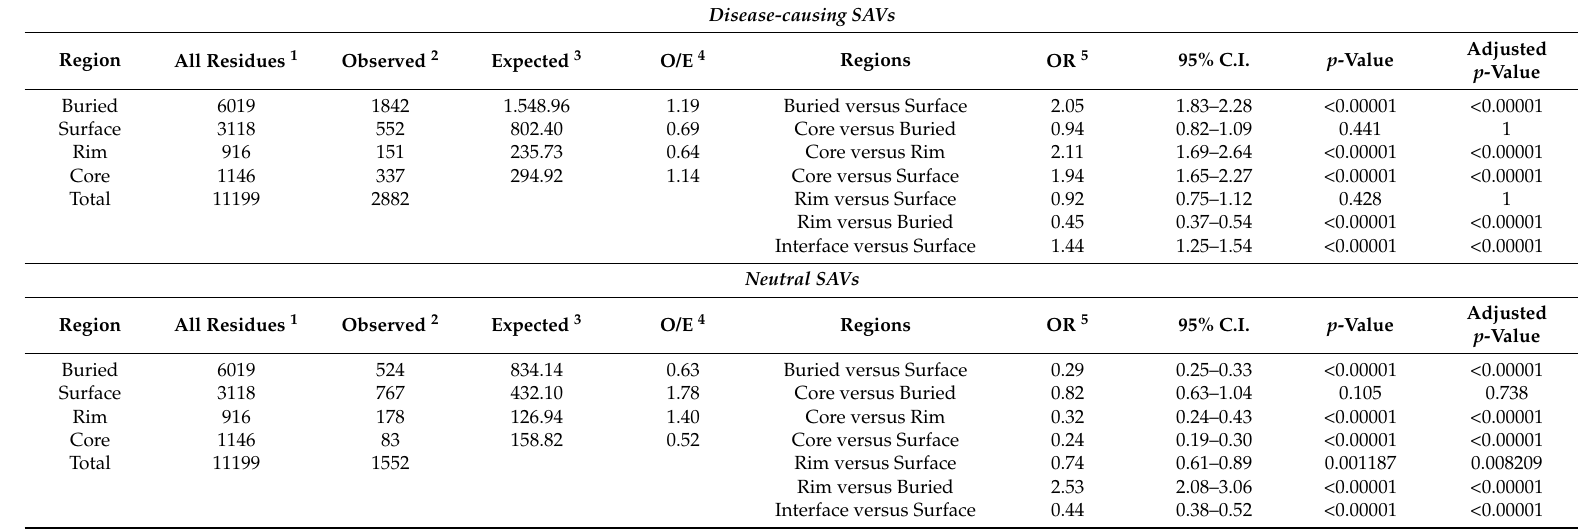
Table 1. Distribution of residues along the different protein regions and odds ratio for disease-causing and neutral